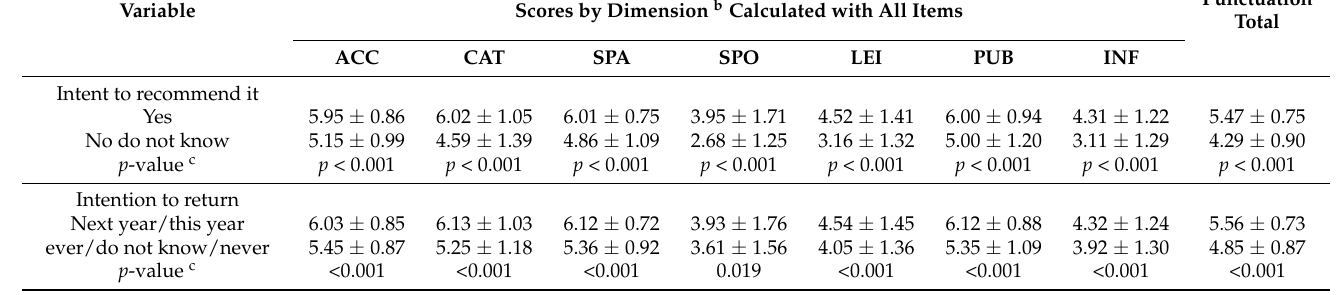
Table 10. Construct validity: association (comparison of means) between the variables of future intention and the scores estimated a . Variable Scores by Dimension b Calculated with All Items